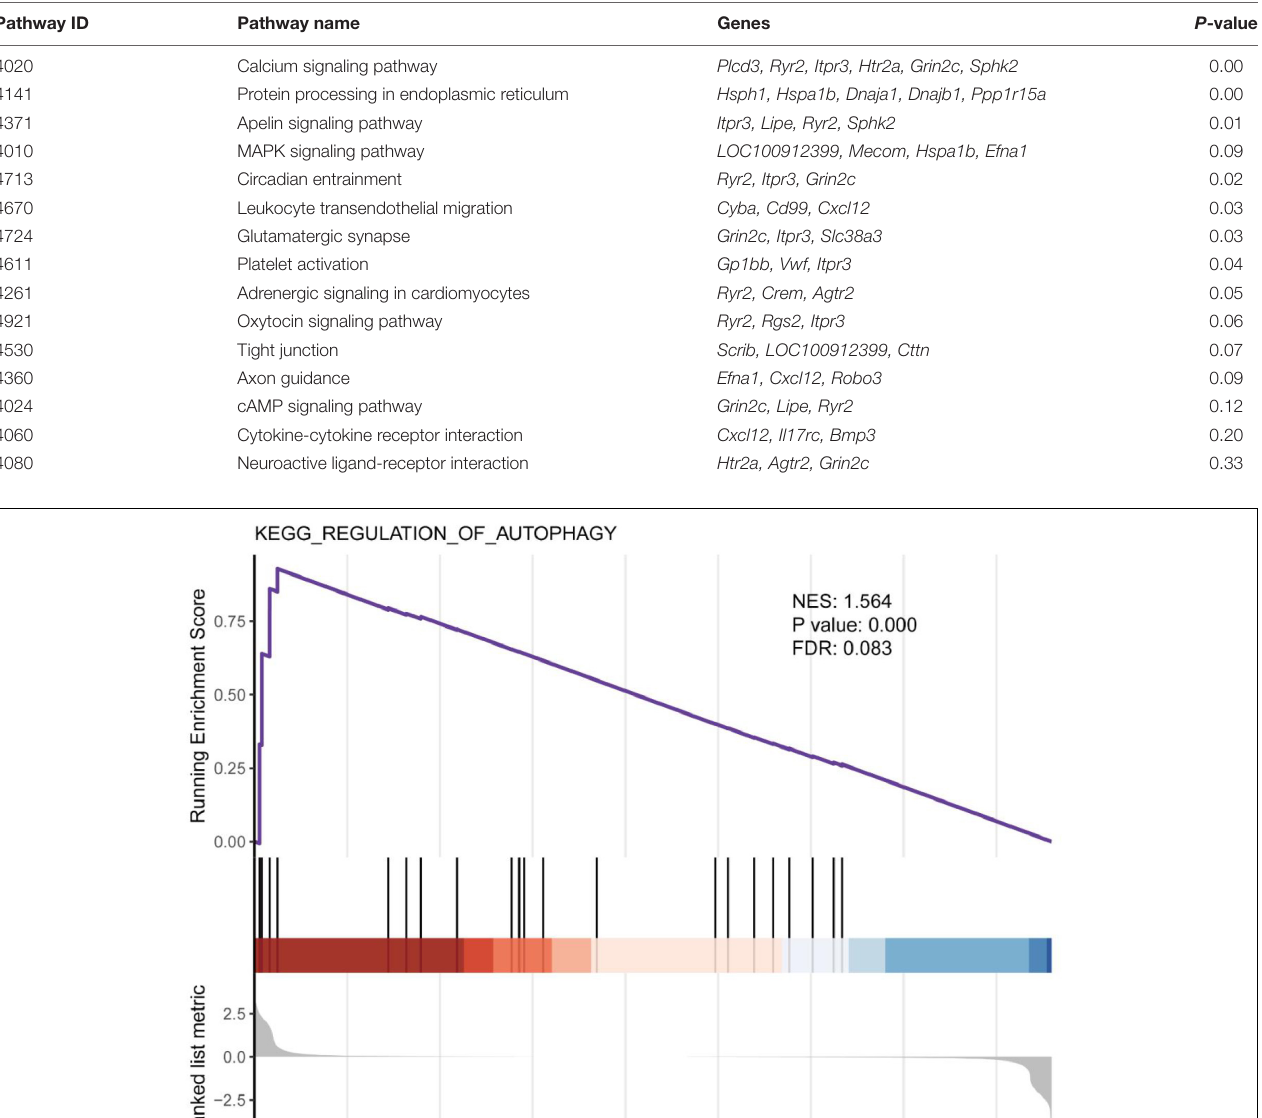
TABLE 5 | Enrichment pathways with more than or equal to three differentially expressed genes.